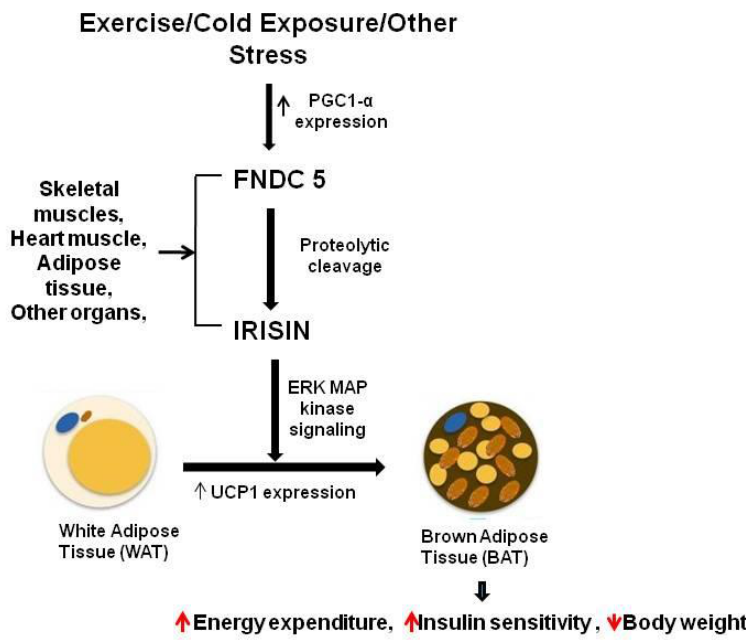
Figure 4. Irisin secretion and its role in fat browning.